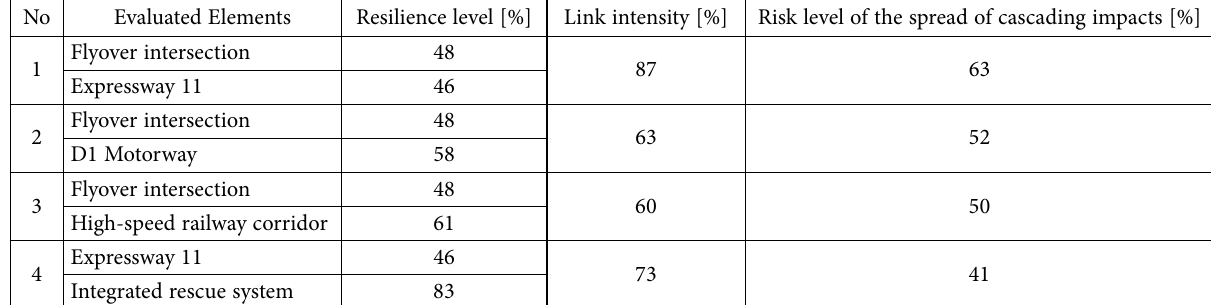
Table 8. Calculated risk level of the spread of cascading impacts